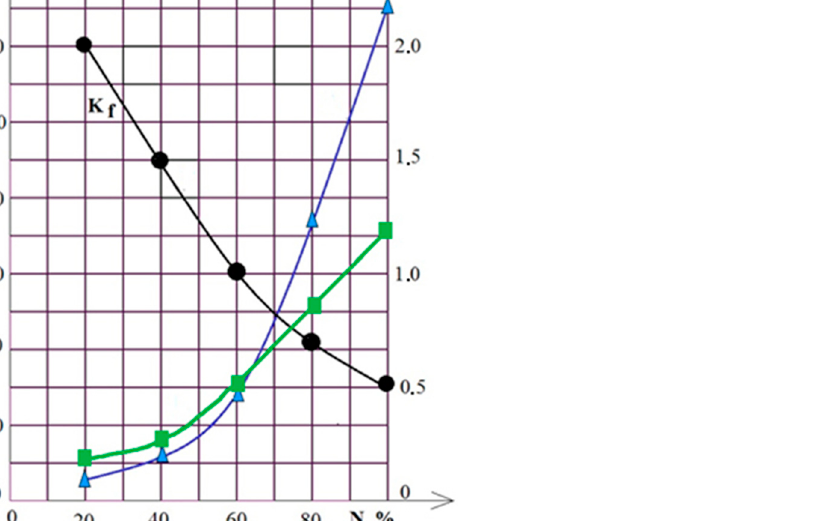
Figure 8. The change in the average square value of the VA signal amplitude in the octave bands 8 kHz (green) and 16 kHz (blue) and their ratio Kf (black) with changes in the power output N% of laser pulses.